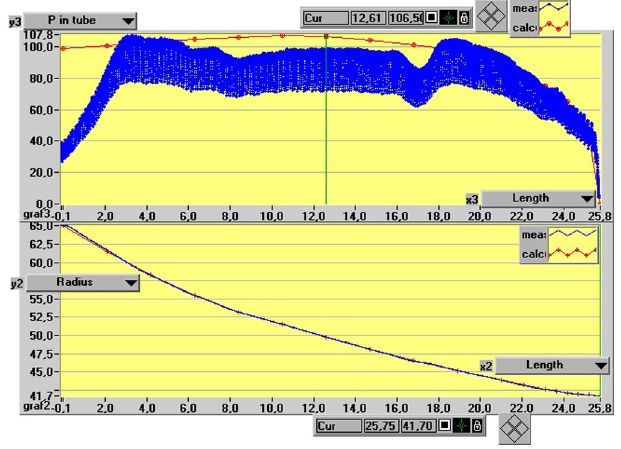
FIG. 14. Typical pressure vs axial displacement and radius vs axial displacement curves.